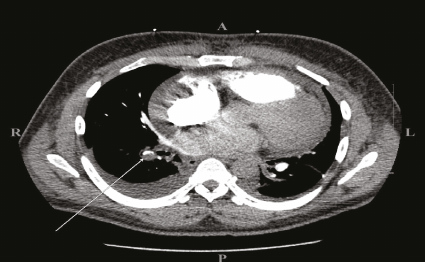
Figure 2: A contrast-enhanced chest computed tomography with pulmonary embolism protocol: large fi lling defect within the distal right lobar pulmonary artery, with thrombus extending into the right lower lobe branches (white arrow). The heart is markedly enlarged with a moderate pericardial e ff usion. Bibasilar consolidations and areas of linear atelectasis versus scarring/ fi brosis at both lower lobes. Bilateral pleural e ff usions, larger on the right than the left. There is no pneumothorax or